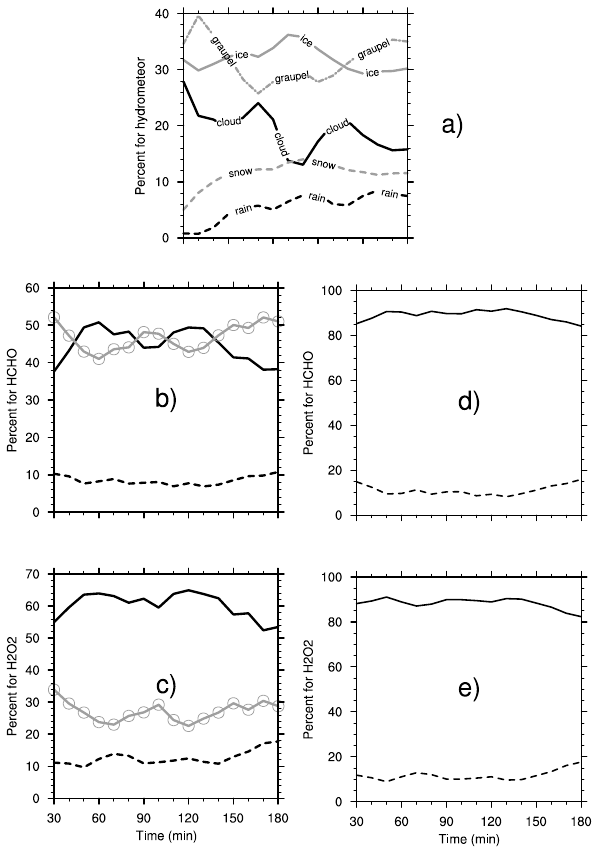
Fig. 15. STERAO case – results for the model domain as a func- tion of time in the simulation sampled every 10min: (a) percent- age of each hydrometeor reservoir relative to the total amount of condensed water, (b) percentage of HCHO in each water category (cloud, rain, precipitating ice) relative to the total amount of HCHO in all the water reservoirs for simulation with retention in ice, (c) the same for H 2 O 2 , (d) the same for HCHO but for simulation without retention in ice, and (e) the same for H 2 O 2 but for the simulation without retention in ice. Solid and dashed black lines (b, c, d, e) are for cloud water and rainwater reservoirs, respectively. Grey line with open circles (b, c) is for the ice-precipitating reservoir.